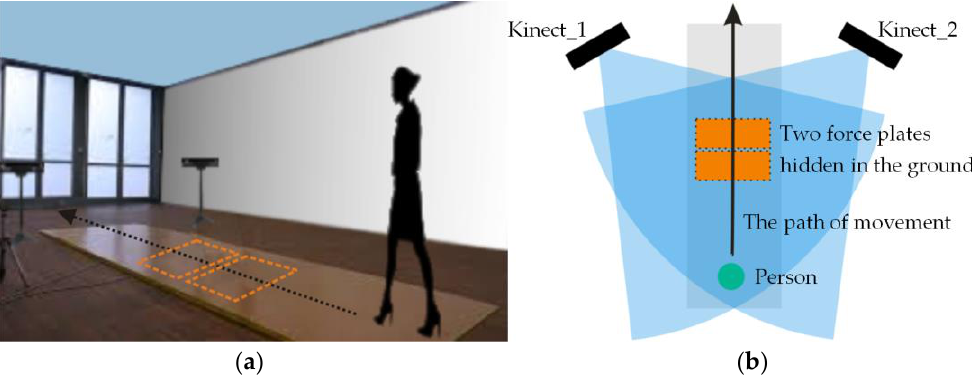
Figure 7. Diagram of human gait measurement: ( a ) a perspective view; ( b ) a view from above.